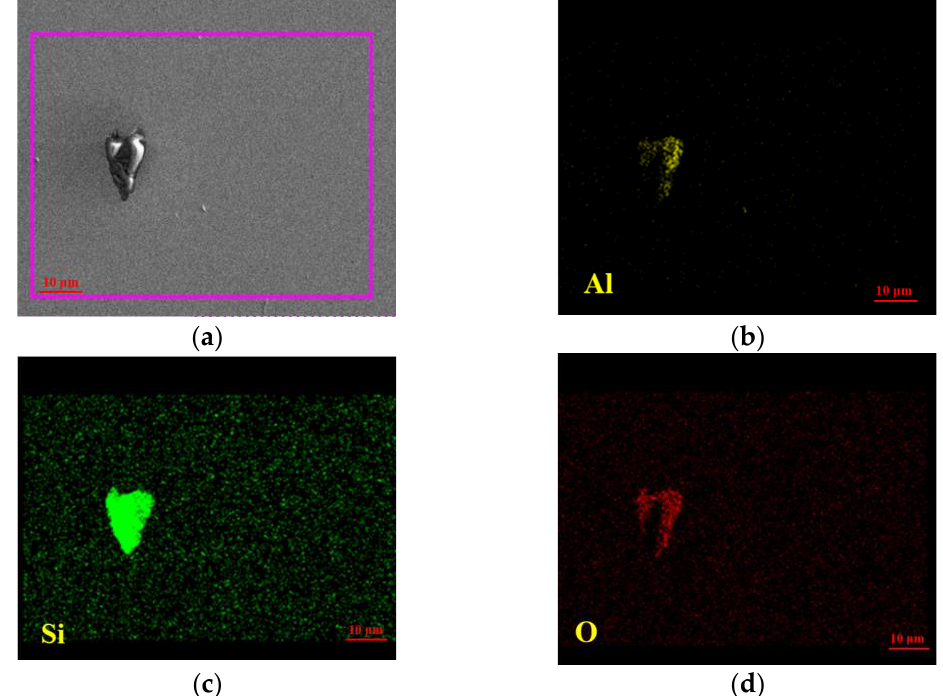
Figure 4. EDS mapping of a typical Al 2 O 3 -SiO 2 inclusion in experimental P91 steel; ( a ) SEM image; ( b ) Al; ( c ) Si; ( d ) O.